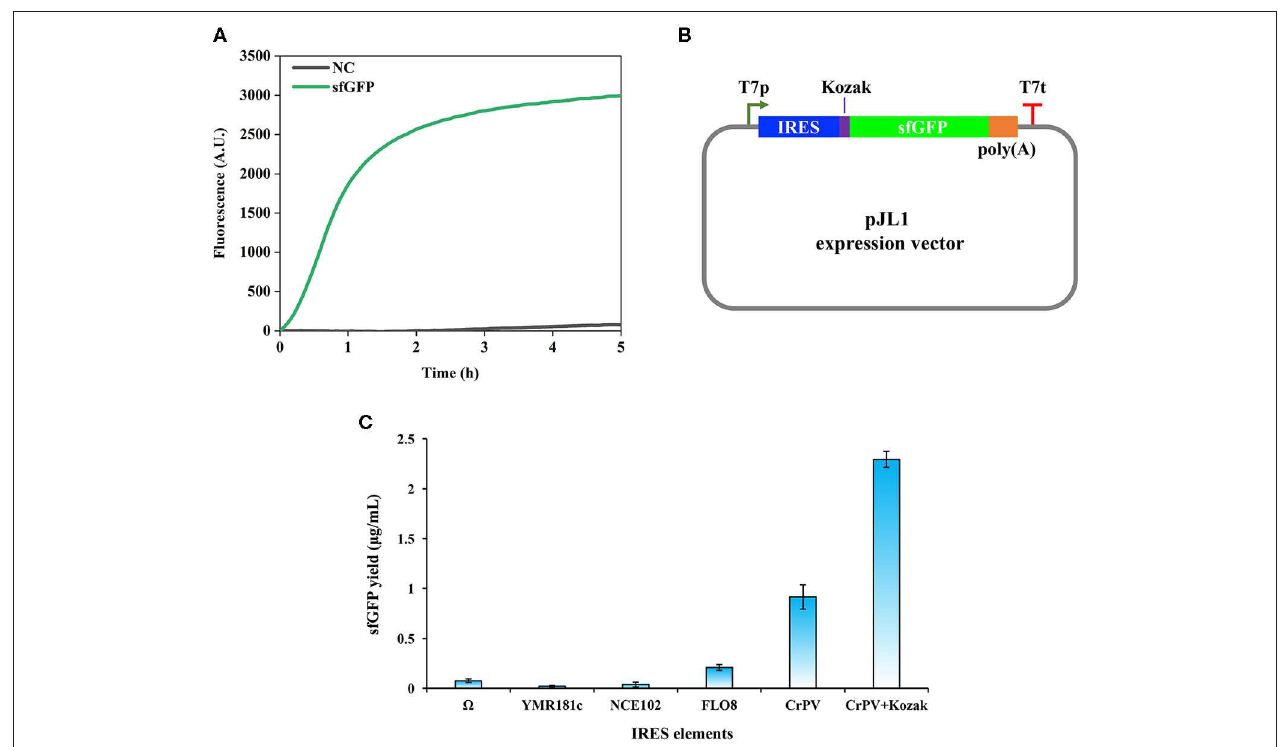
FIGURE 1 | Cell-free protein synthesis of superfolder green fluorescent protein (sfGFP) using Pichia pastoris extract. (A) Time course of sfGFP synthesis with online fluorescence measurement. NC, negative control without plasmid in the reaction. (B) Design of expression vectors based on the pJL1 plasmid. IRES, internal ribosome entry site; Kozak, a 6 bp sequence (GAAACG); poly(A), a 50 bp poly(A) tail; T7p, T7 promoter; T7t, T7 terminator. (C) Effects of IRES elements on the cell-free synthesis of sfGFP in a P. pastoris CFPS system. Values show means with error bars representing standard deviations (s.d.) of at least three independent